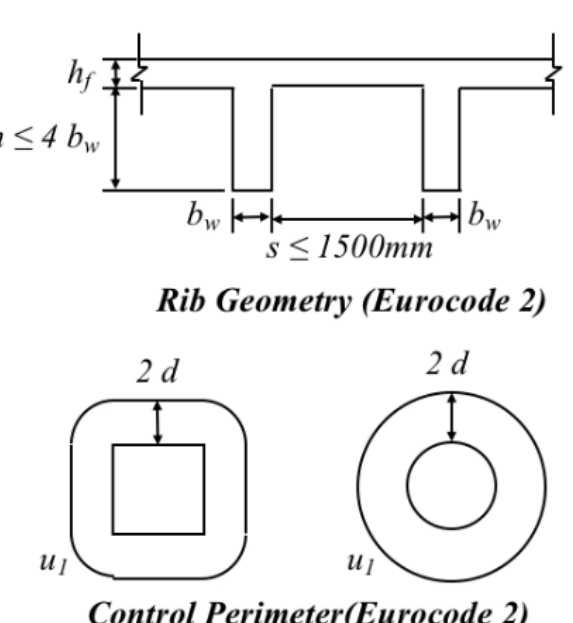
Figure 2. Rib geometry and control perimeter according to Eurocode 2